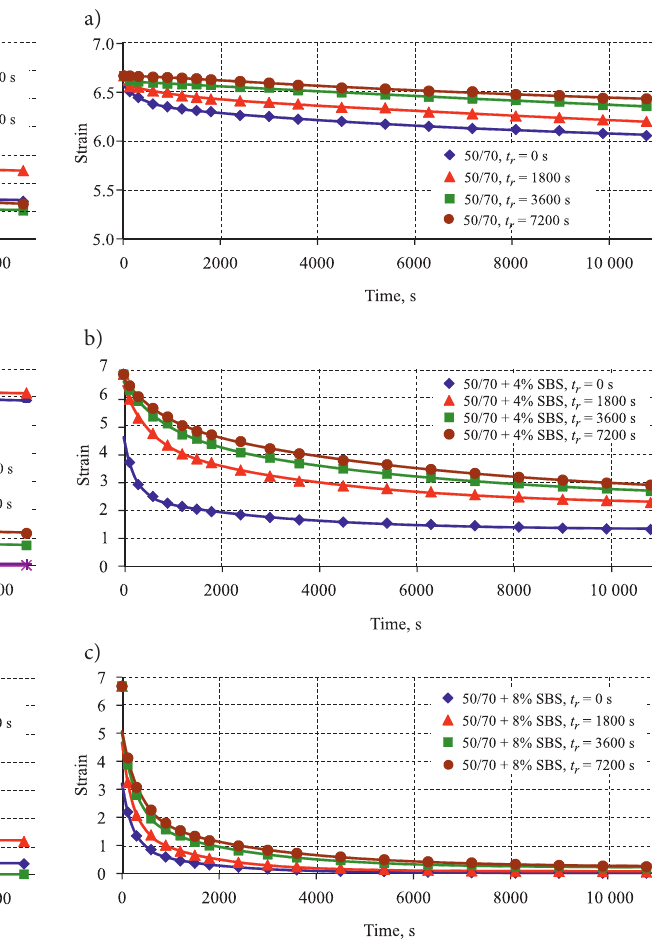
Fig. 7. Inverse creep curves of asphalt binders tested at: a – 5 °C; b – 25 °C; c – 35 °C; the Dual Kelvin+Maxwell model